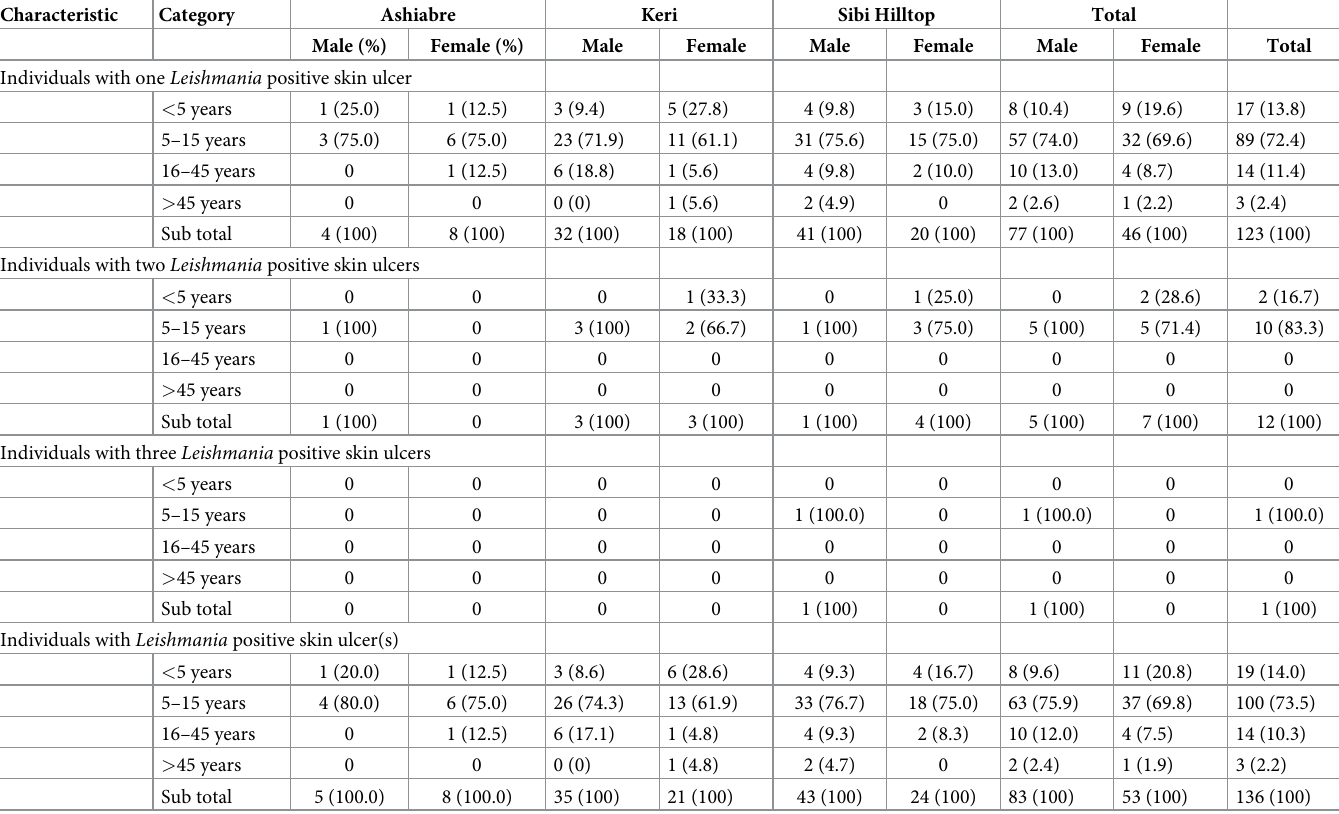
Table 3. Distribution of individuals with Leishmania positive skin ulcers by age, sex, and community of residence. Characteristic Individuals with one Leishmania positive skin